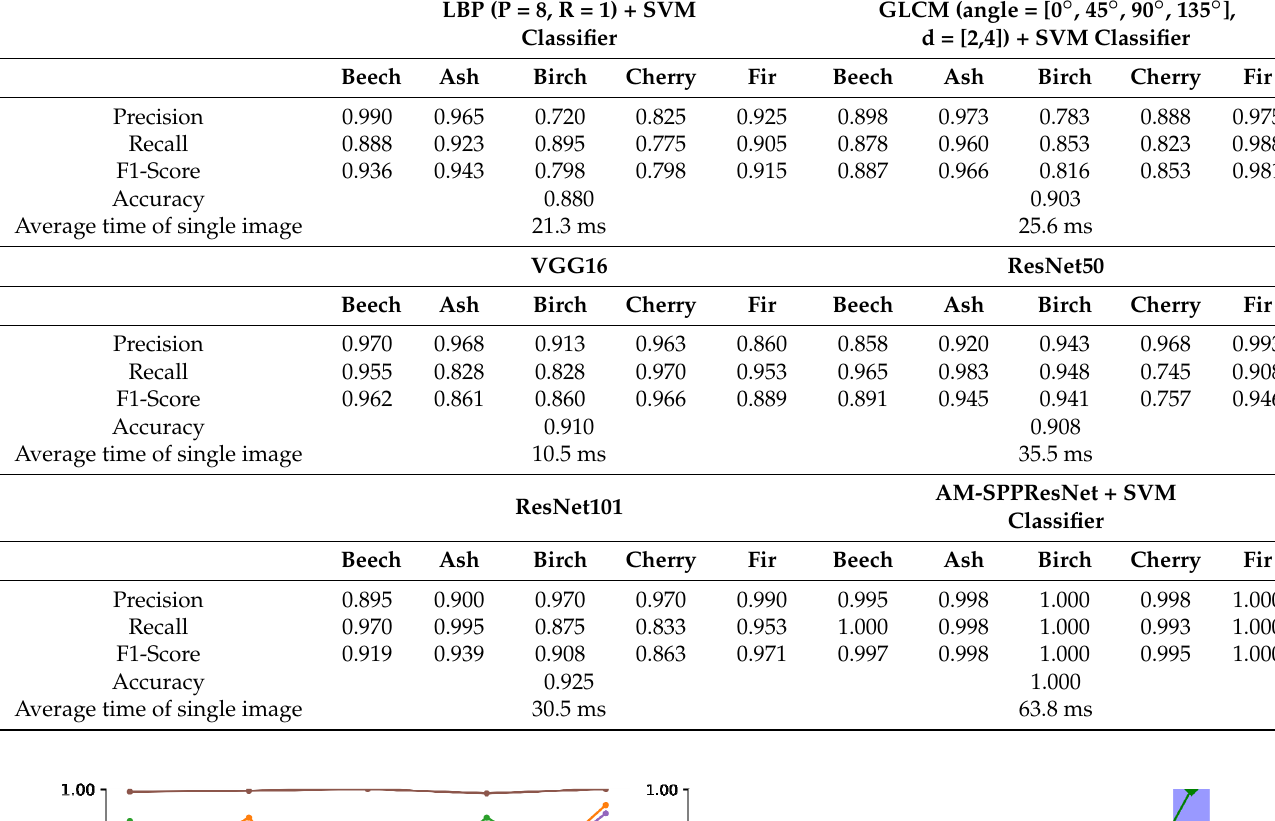
Table 5. Prediction matrix of different models applied in identification of sawn timber tree species.